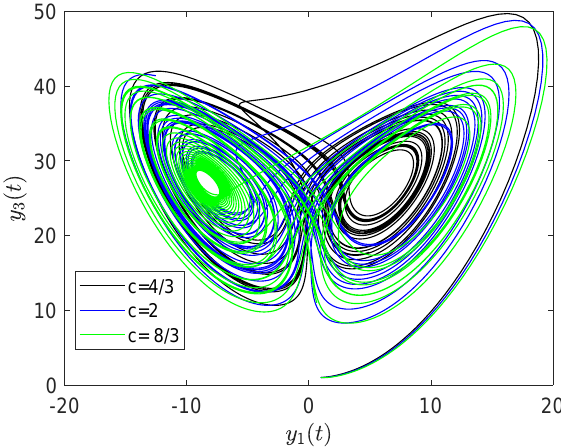
Figure 22. Phase portraits of y 1 and y 3 when varying c .